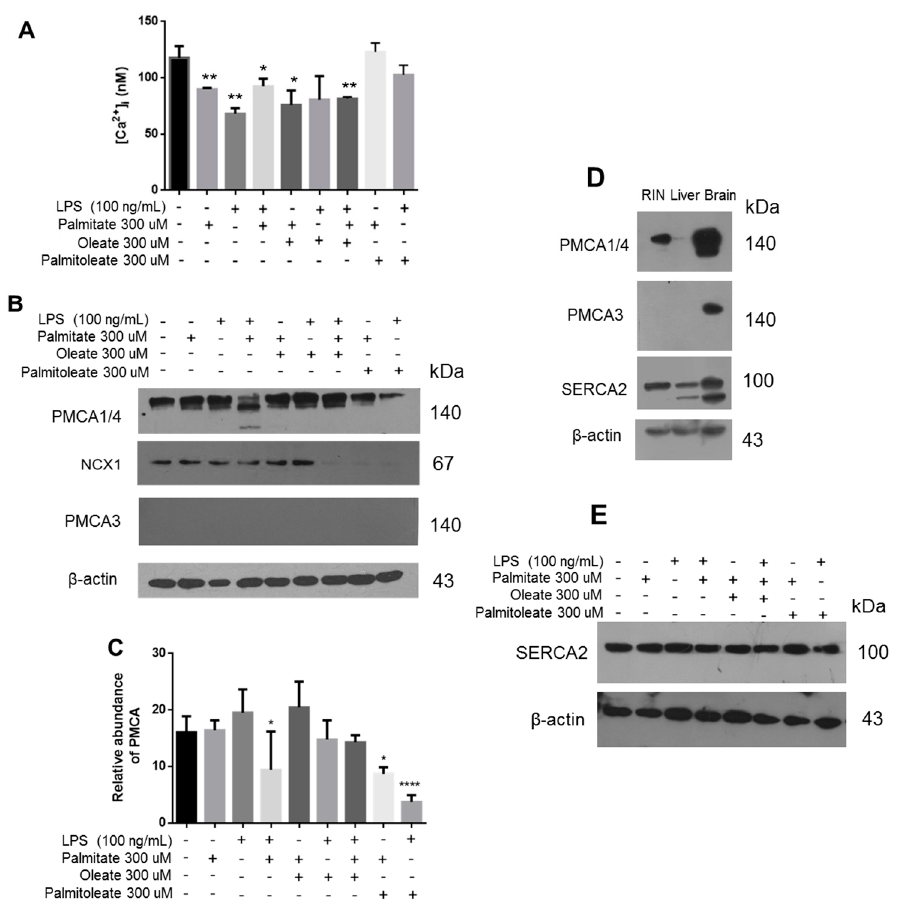
Figure 7. The treatment with unsaturated fatty acids regulates the expression of calcium transporting proteins. ( A ) Quantification of intracellular [Ca 2 + ] under lipotoxicity conditions. * p < 0.05, ** p < 0.01 compared to control ( n = 3, mean ± SD). ( B ) Expression of targets PMCA1 / 4, NCX1 and PMCA3, which are regulated by oleic and palmitoleic acid. ( C ) Quantitative characterization of the expression of PMCA1 / 4, the analysis was based on three di ff erent experiments. * p < 0.05, **** p < 0.001 compared to control ( n = 3, mean ± SD). ( D ) Validation of antibodies anti-PMCA1 / 4, anti-PMCA3 and anti-SERCA2 in RIN-m5F cells, liver and brain tissues. ( E ) Western blot of SERCA2. β -actin was used as a loading